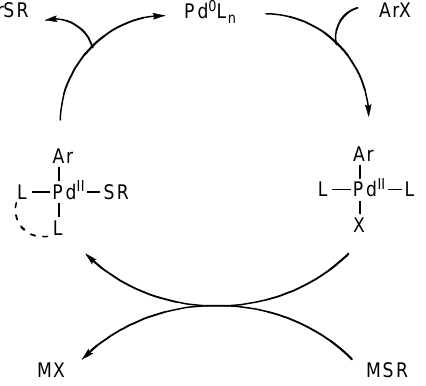
Scheme 1. General mechanism for Pd-catalyzed arylthioether